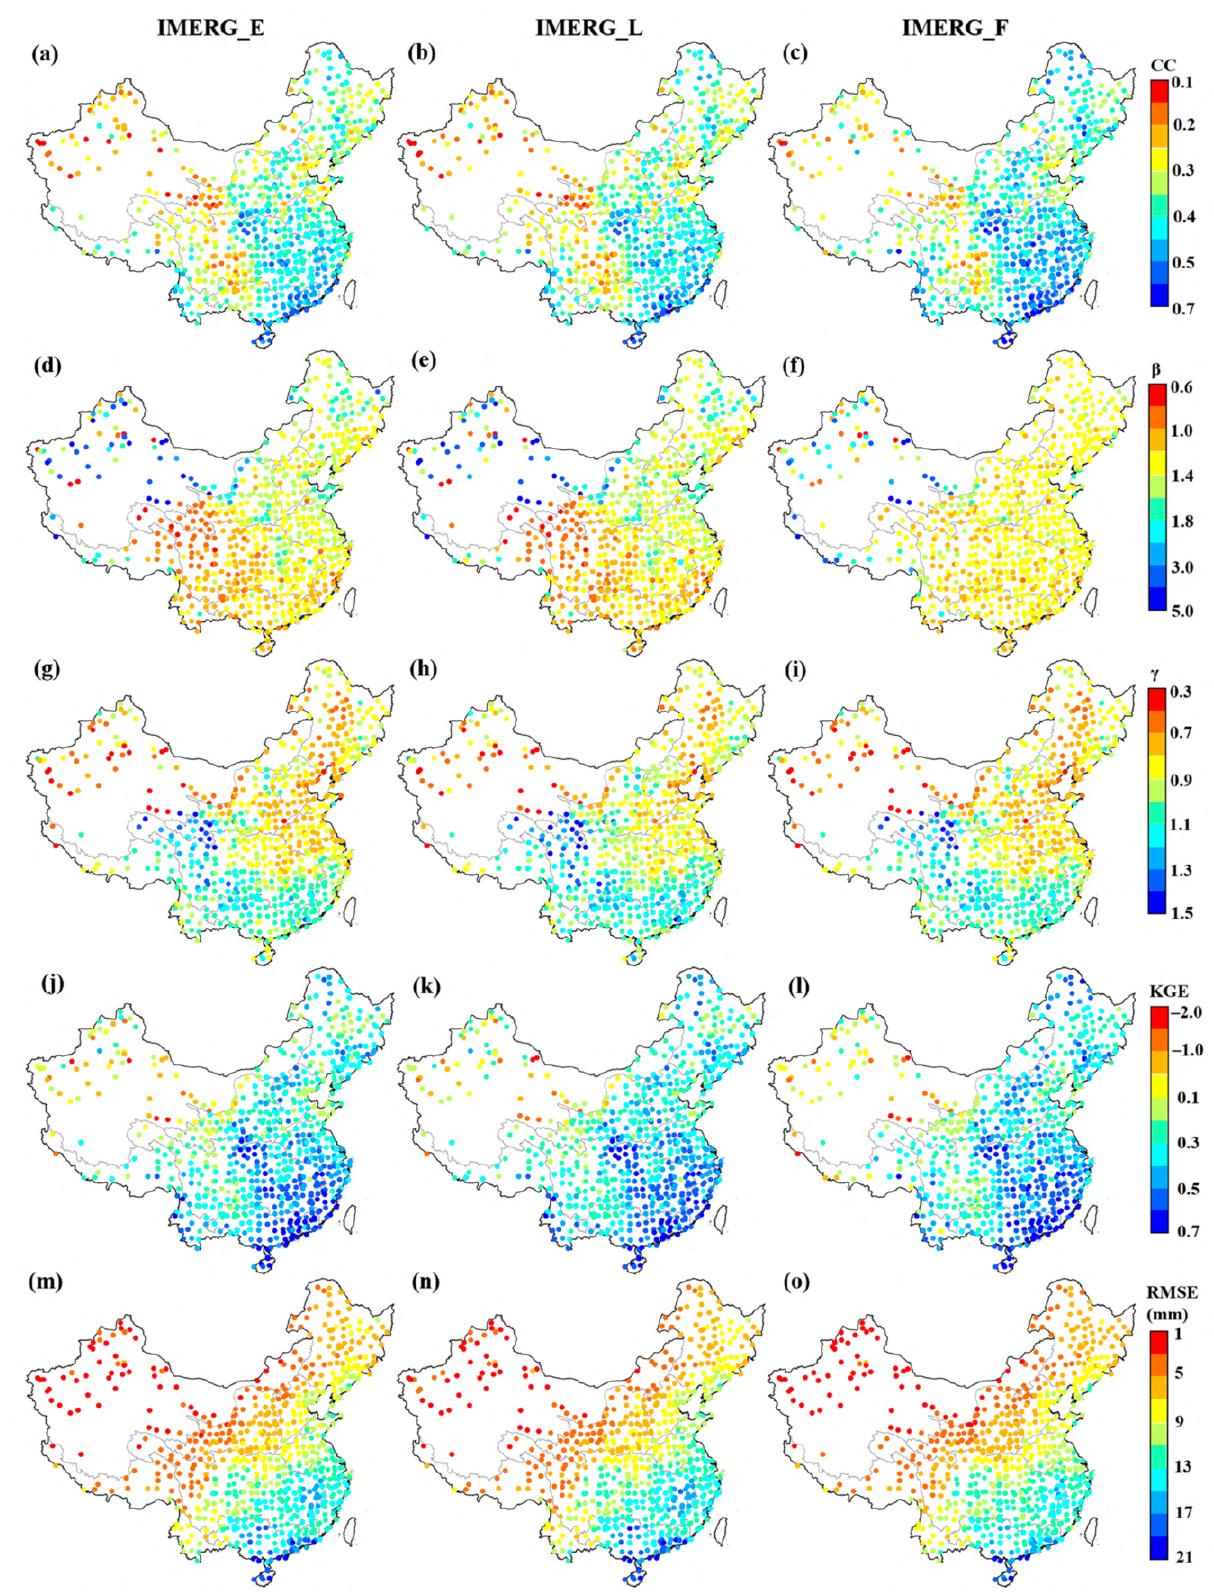
Figure 2. Spatial distribution of statistical metrics (CC ( a – c ); β ( d – f ); γ ( g – i ); KGE ( j – l ); and RMSE ( m – o )) from IMERG_E (Column 1), IMERG_L (Column 2) and IMERG_F (Column 3) at daily level from 2008 to